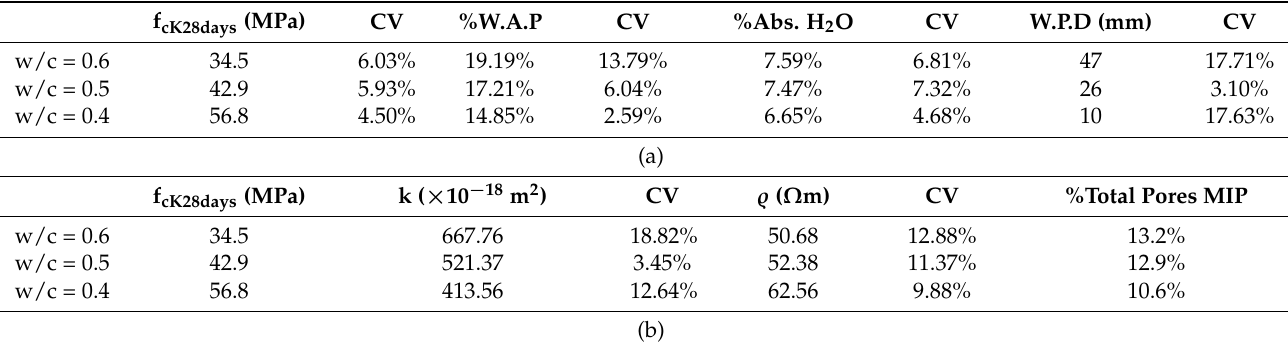
Table 4. Standardized tests results. ( a ) Mean compressive strength values at 28 days (f ck28days ) (UNE 12390-3:2009), %H 2 O accessible porosity (W.A.P) and %absorbed H 2 O (Abs.Water) (UNE 83980) and H 2 O penetration depth under pressure (W.P.D) (UNE 83-309-90). ( b )air permeability coefficient (k) (UNE 83981), electrical resistivity ( (cid:36) ) (UNE 83988-1:2008), and %Total pores MIP